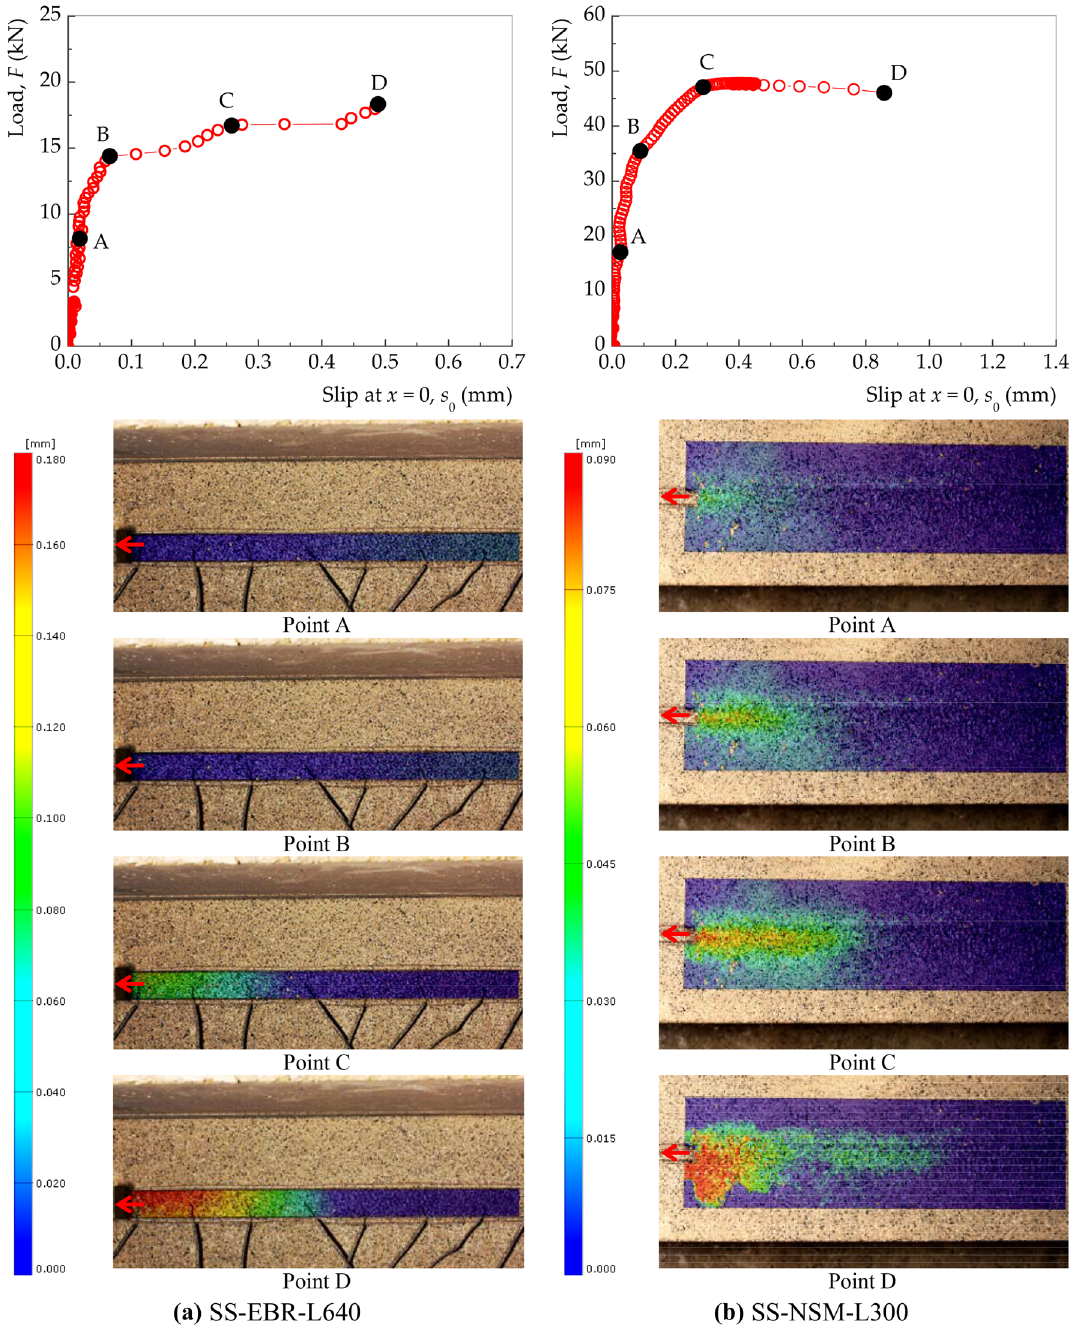
Fig. 5 Displacement field obtained from the DIC software at different points of the load–slip responses of the specimens: a SS- EBR-L640; and b